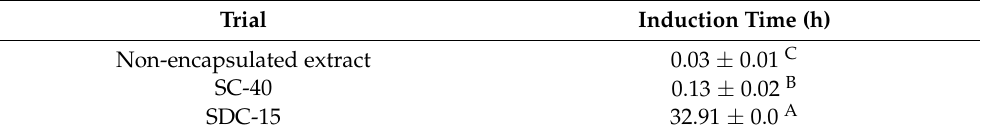
Values with the same capital letter are not statistically different ( p > 0.05). SC: microparticles ob-